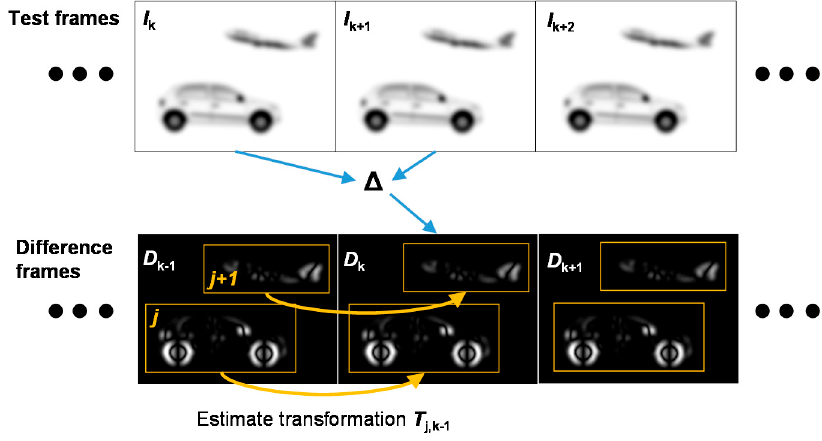
Figure 2. Illustration of the clustering/tracking approach: computing difference frames from the test frames give clouds of points indicating moving objects. These clouds are then clustered and bounding boxes are established. The estimated transformations between corresponding point clouds on successive difference frames give the trajectory of the relevant object.